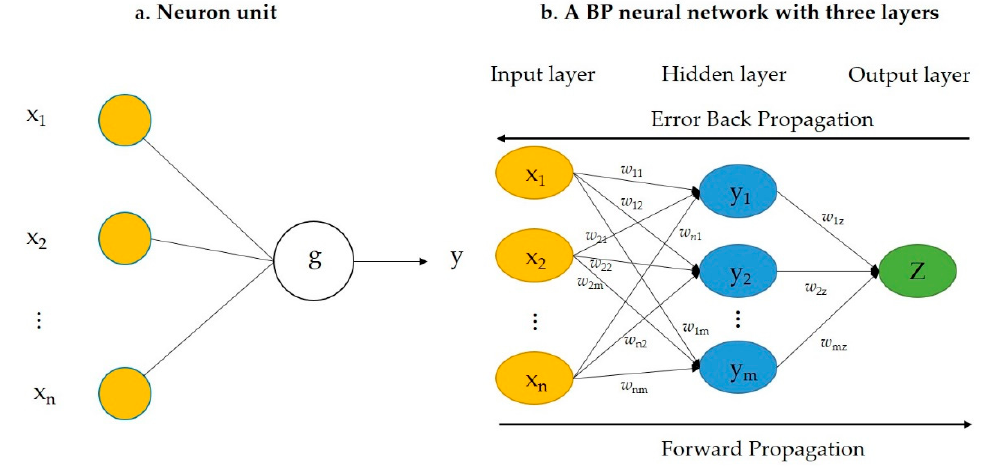
Figure 2. Neural network interpretation diagram. ( a ) is a schematic diagram of a neural unit; ( b ) is a BP neural network with the three layers [38].